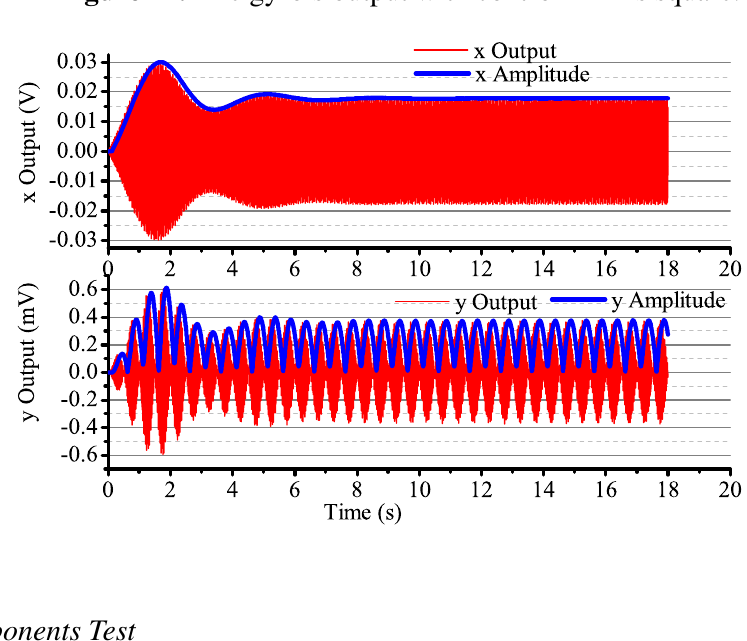
Figure 22. The gyro’s output with control in Ω is